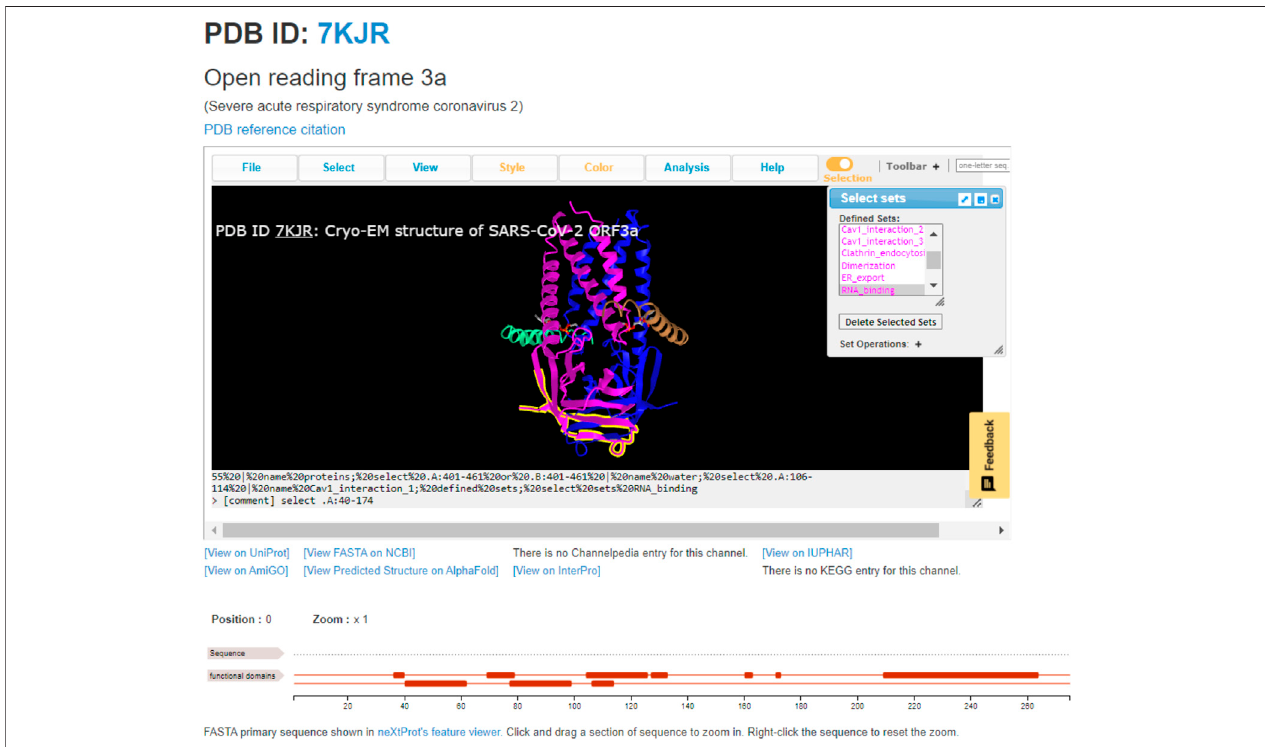
FIGURE1| TheannotatedSARS-CoV-2openreadingframe3aionchannel(PDB ID:7KJR)withRNA-binding domain highlighted.Thisdomain isthecytoplasmic side of the cell membrane, where it may be involved in binding viral RNA and apoptosis.